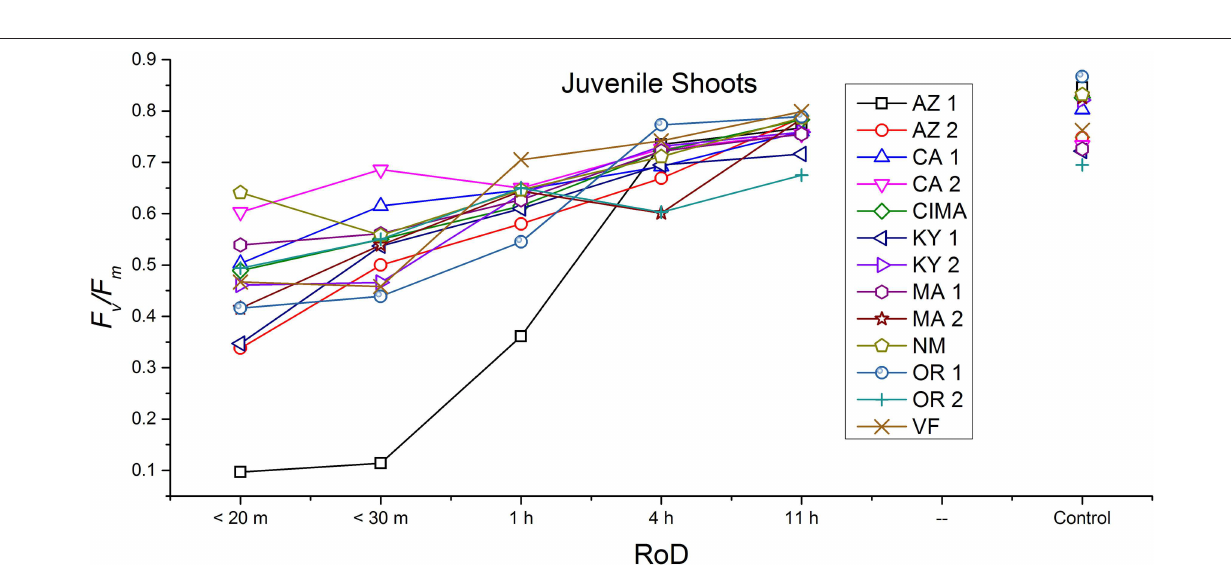
FIGURE 5 | Reaction norms for juvenile shoots from 13 ecotypes exposed to five rates of drying (RoD) 24h post